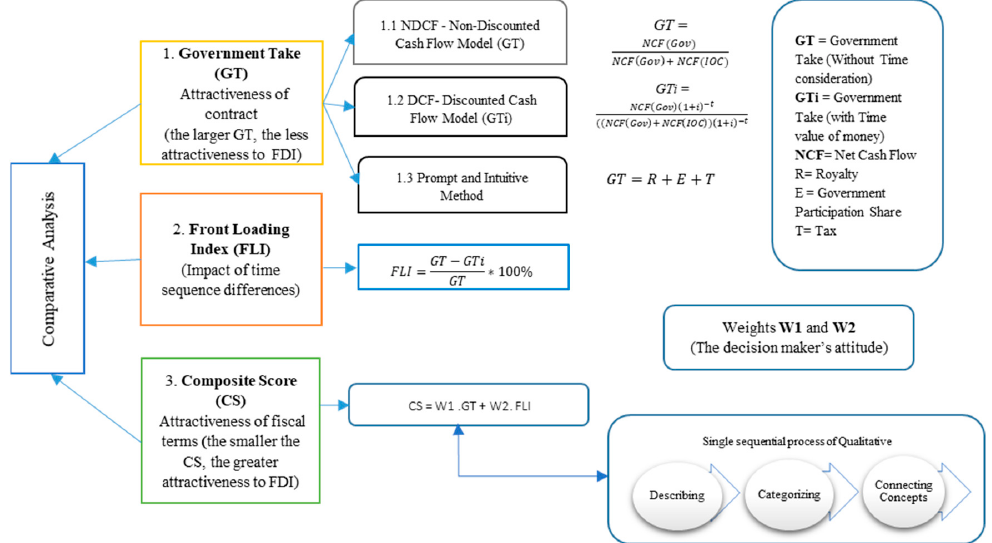
Figure 1. Proposed Modeling Framework.